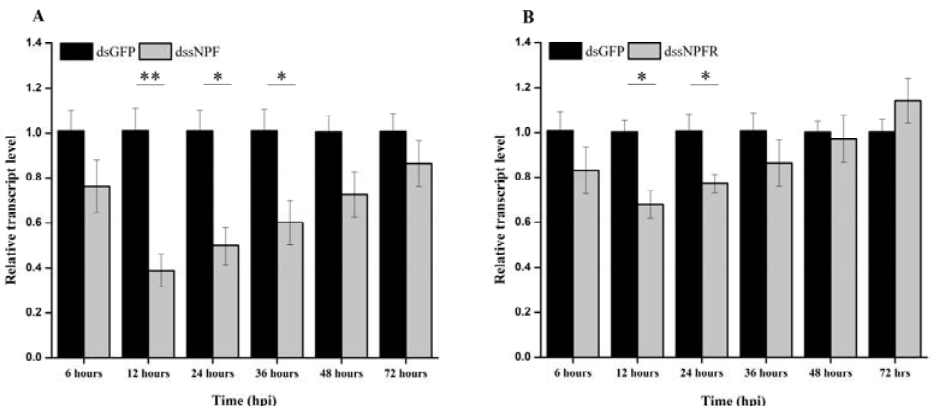
Figure 6. RNAi ‐ mediated knockdown of sNPF ( A ) and sNPFR ( B ) expression levels in A. pisum . The transcript patterns in pea aphids injected with sNPF (or sNPFR) dsRNA and GFP dsRNA (control) were measured via qRT ‐ PCR and normalized against RPL7. Acronyms used on X ‐ axis:, hpi (hours post ‐ injection). The bars correspond to the average of three independent biological replicates. Statistical analysis was performed using Student’s t ‐ test (mean ± S.E.; * p < 0.05; ** p < 0.01).